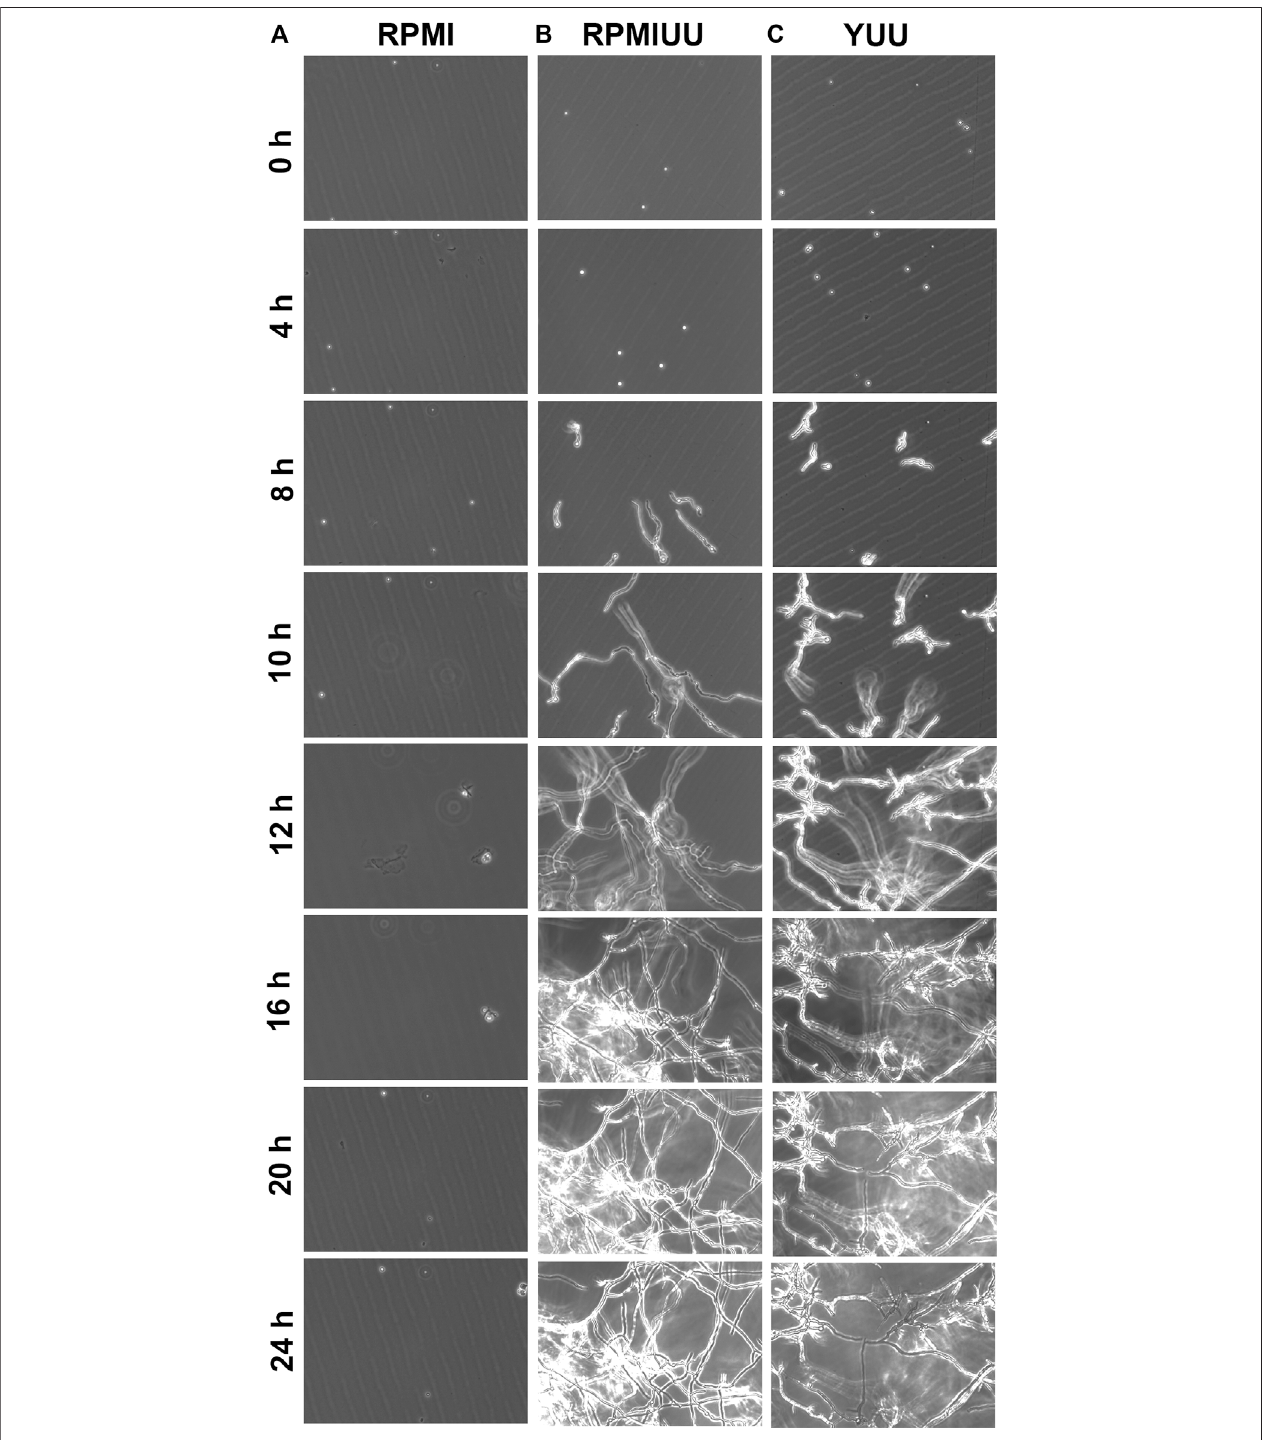
FIGURE1| Phase-contrast micrographsofbio fi lmformationinRPMI, RPMIUU,and YUUmedia. 1×10 4 conidiaof A.nidulans weregrown inRPMI (A) ,RPMIUU (B), and YUU (C) media inpolystyrene24-well plates for 24 hat 37 ° C.The images werecaptured everyhour from thesame fi eld usingCytation-5 (Biotek). Magni fi cation of 20 x was used in all